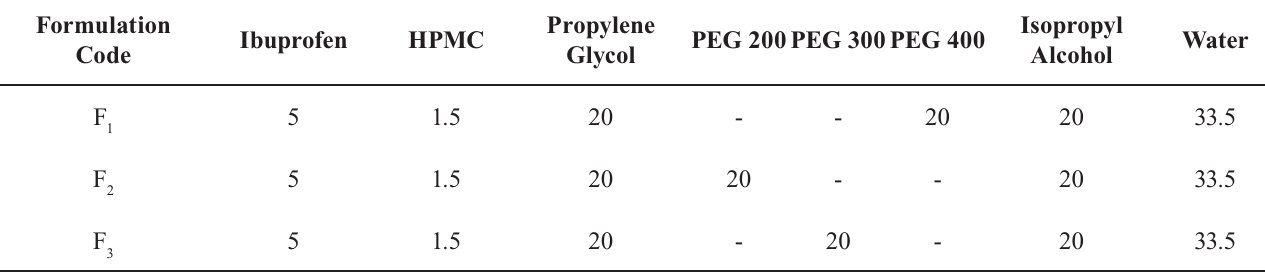
TABLE I - Topical patch composition % (w/w) with co-solvent variation